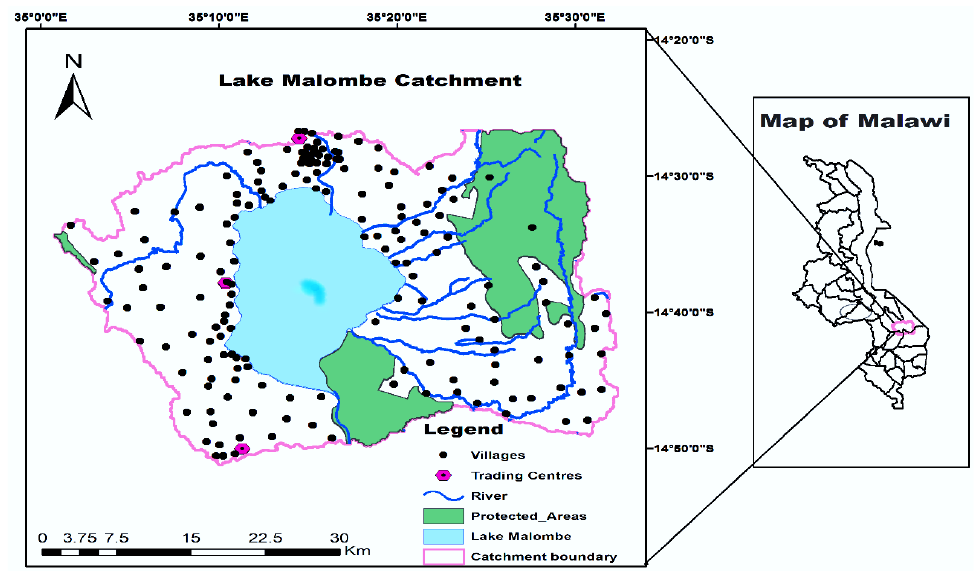
Figure 2. Map of Lake Malombe catchment (Makwinja et al. 2021a).